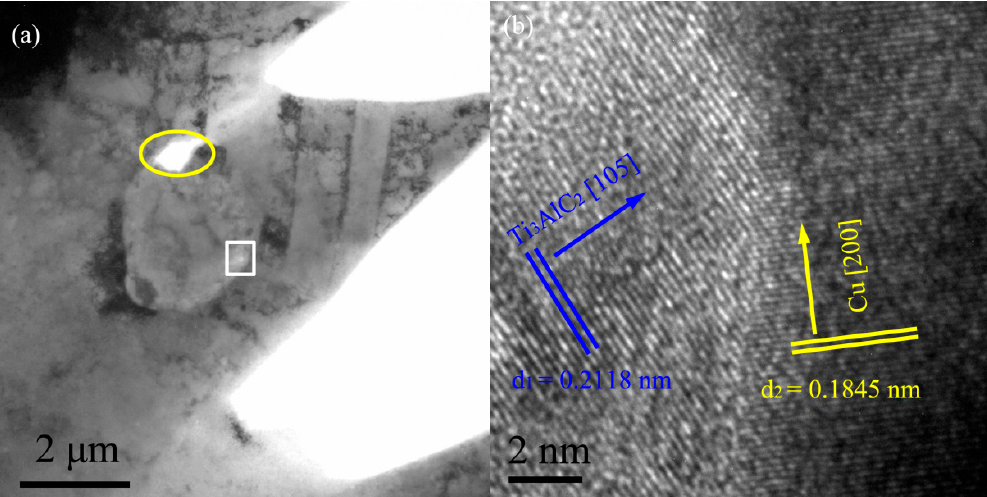
Figure 7. The TEM images of the Ti 3 AlC 2 -Gd 2 O 3 /Cu composite: ( a ) bright field image; ( b ) high resolution image; a micropore was indicated by the yellow circle and the high resolution image was from the white box in Figure 7a.